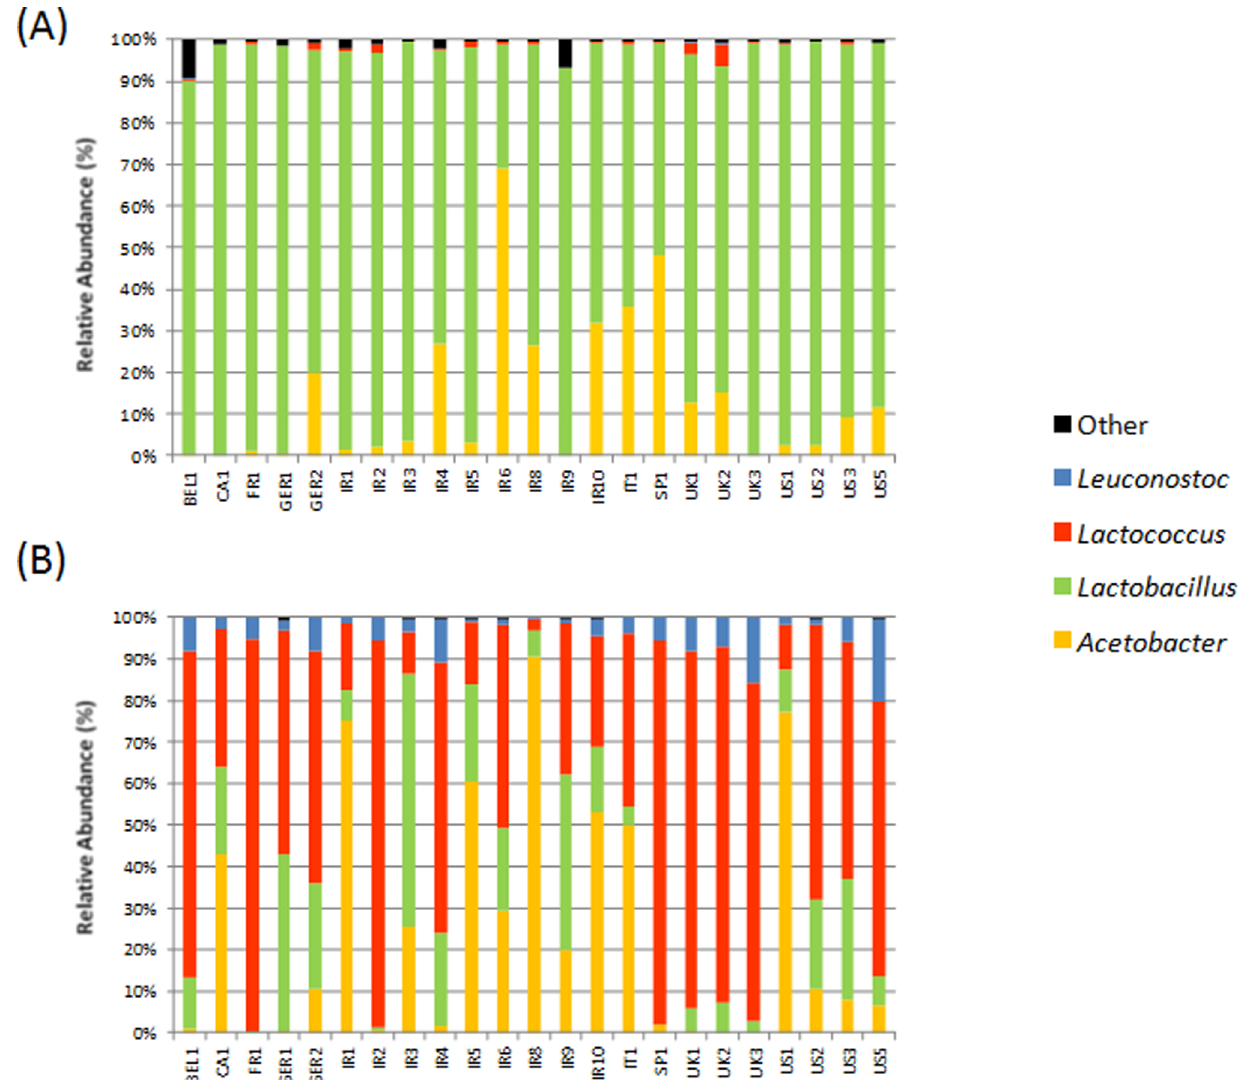
Figure 3. 16S phylogenetic composition of the bacterial component of the kefir grain (A) and kefir fermented milk (B) at genus level.